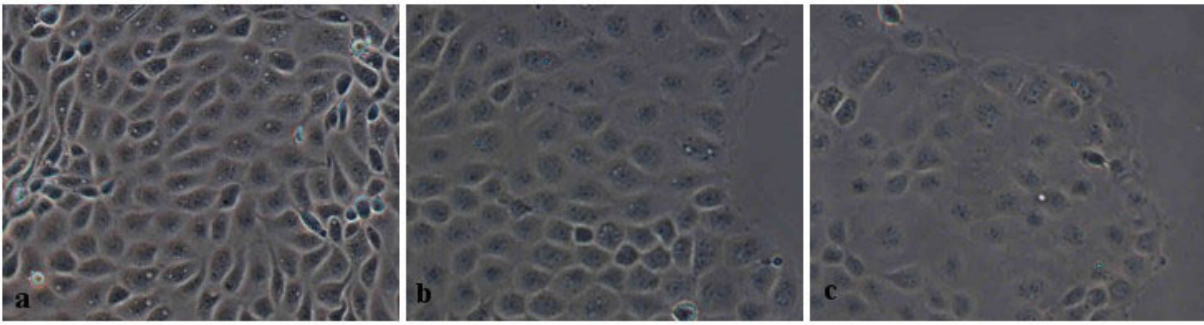
Figure 5. Representative microphotographs demonstrating the effects of SBA on the morphology and growth of IPEC-J2 cells. Cells were cultured to confluence and incubated with the 0 mg/mL ( a ), 0.5 mg/mL ( b ), 2.0 mg/mL ( c ) of SBA for 48 h; 0 mg/mL of SBA treated cells are shown as the control. Magnification, 200×.